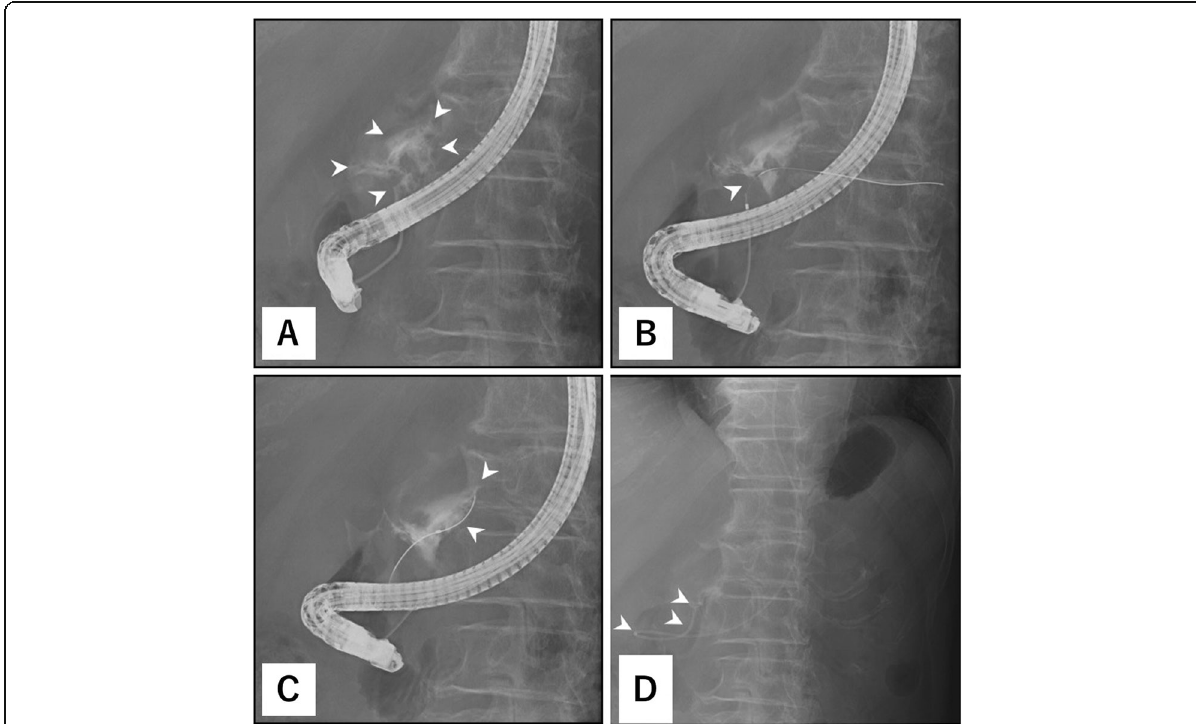
Fig. 2 Preoperative endoscopic retrograde pancreatography and placement of an endoscopic nasopancreatic drainage catheter. Endoscopic retrograde pancreatography showed leakage of contrast medium (arrowhead) from the injured major pancreatic duct, and the pancreatic tail could not be visualized ( a ). A guidewire was passed across the break (arrowhead) to the distal pancreatic duct ( b ); however, the endoscopic nasopancreatic drainage (ENPD) catheter was not advanced across the rupture because the guidewire and catheter were warped (arrowhead) at the injury site ( c ). A 5-French ENPD catheter was placed at the injury site (arrowhead) preoperatively ( d